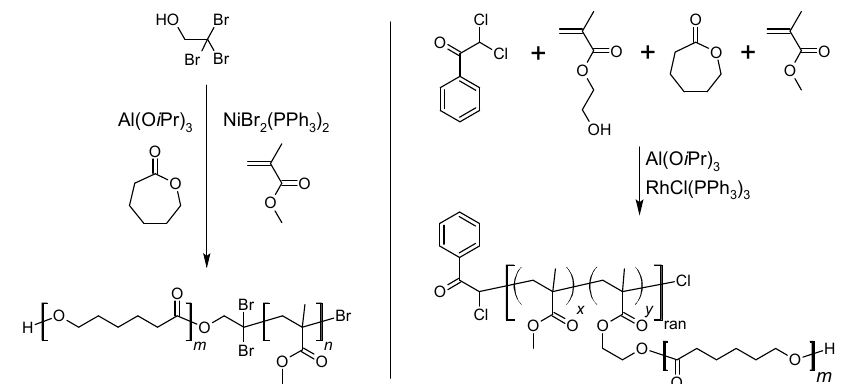
Figure 2. Synthesis of ( left ) diblock and ( right ) graft copolymer by concurrent ATRP and ROP [44].